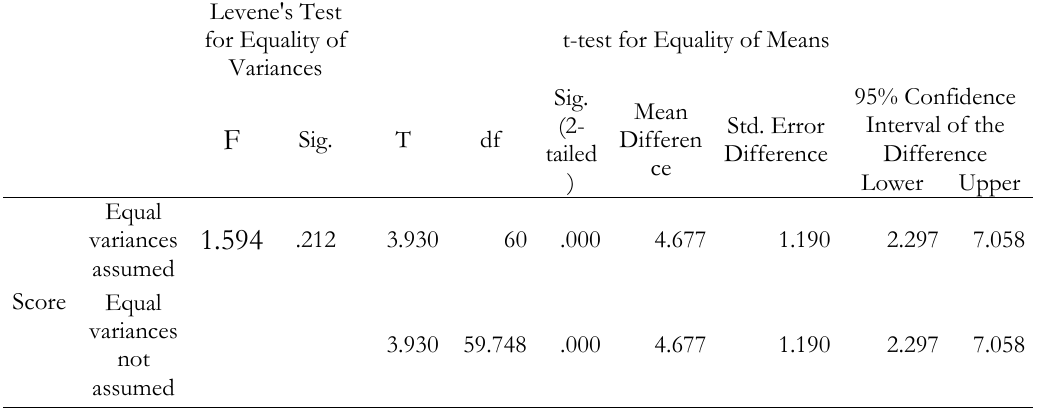
TABLE 1. Independent Sample t-test for Experimental Group and Control